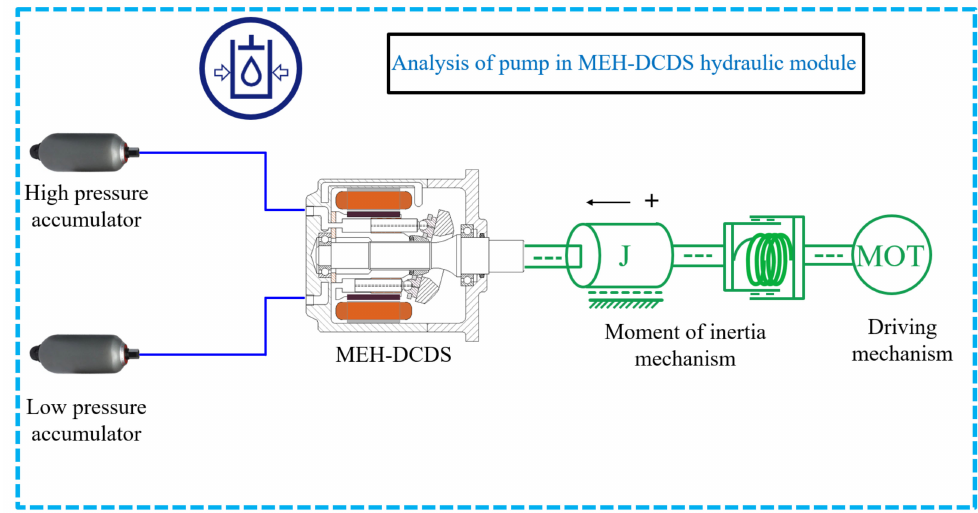
Figure 3. Analysis model diagram of pump in MEH-DCDS hydraulic